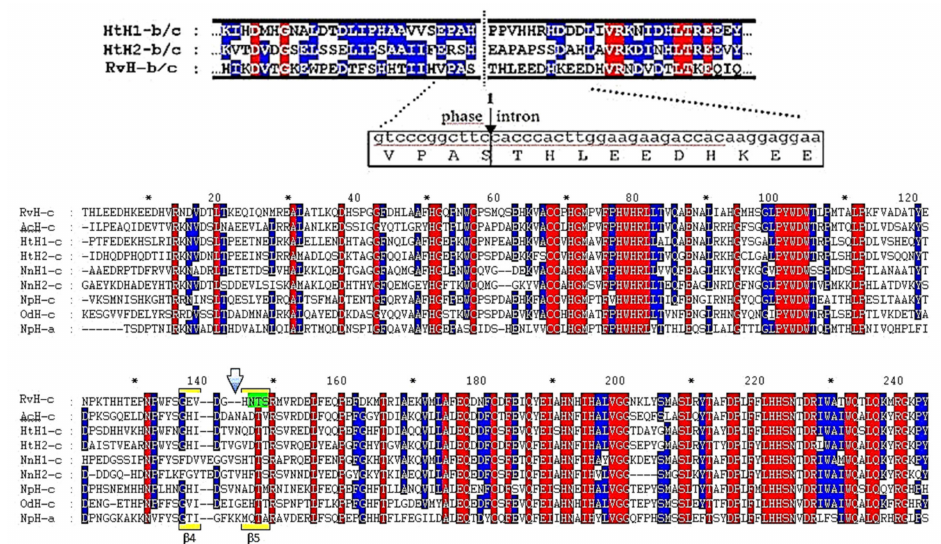
Figure 18. Comparative analysis of the AAS of RvH-c with FUs from other hemocyanins. Conservative sites of the AAS (in blue and red) and N -linked glycosylation site of RvH-c (in green) [31].